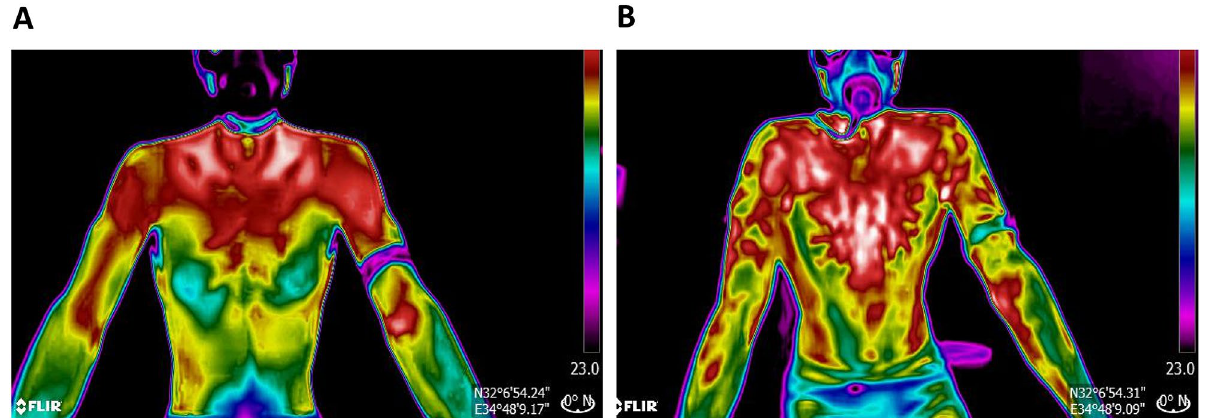
Figure 2. A thermal image of a representative participant ( A ) at the beginning of the exercise test and ( B ) at the end of the exercise test where the tree-shaped hotspot areas can be